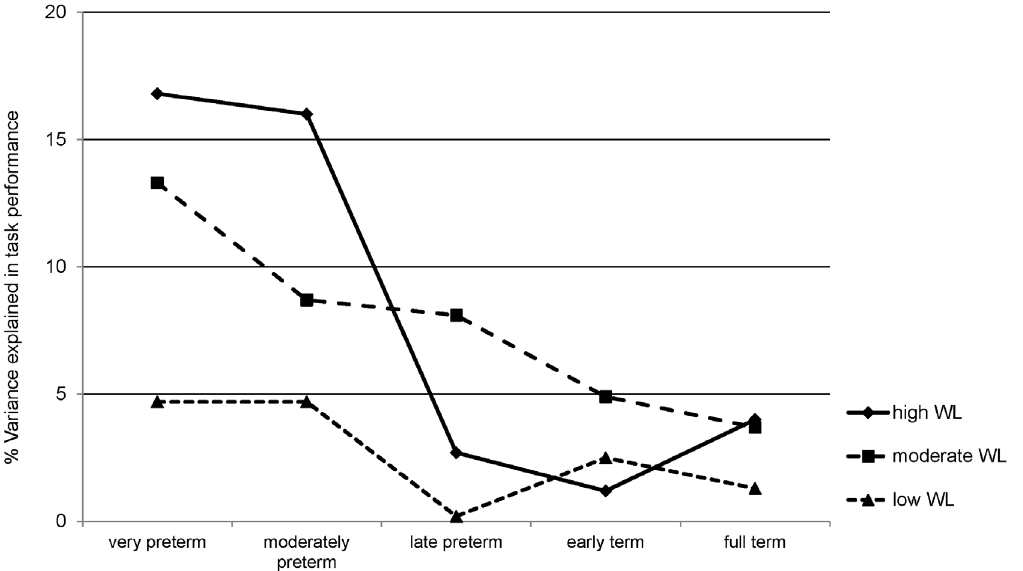
Figure 2. Variance explained by biological factors according to workload and gestational age. Symbols represent the unique percentage of variance explained ( R 2 ) by biological factors (GA, birth weight, OPTI score) in children’s performance on low, moderate, and high cognitive workload (WL) tasks at age 8;5 years according to gestational age groups ( n =1326).